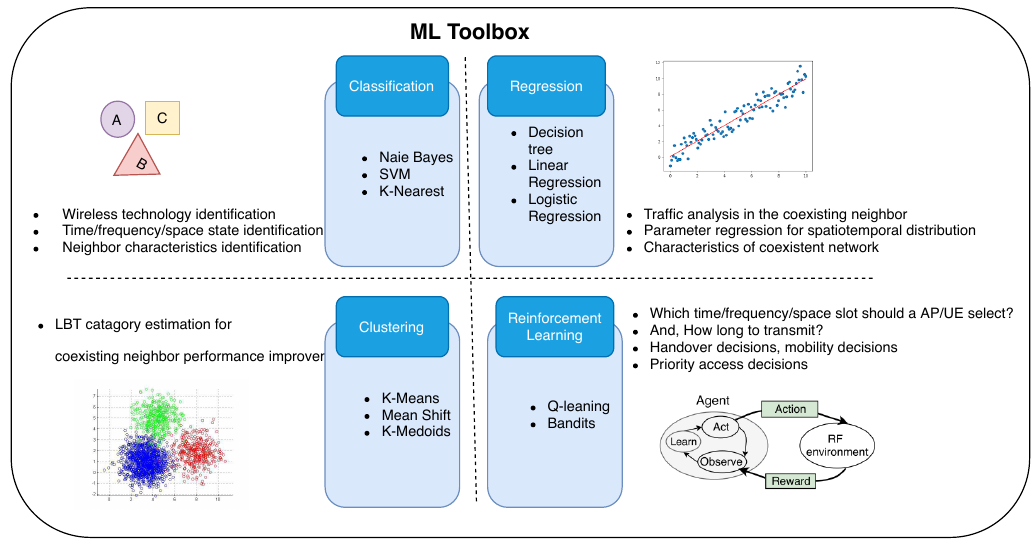
Figure 8. ML as a toolbox for